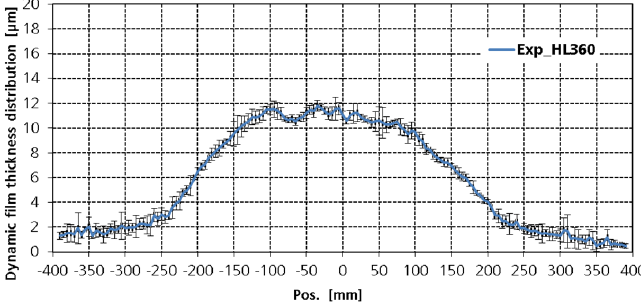
Figure 5. Measured dynamic film thickness distribution on a flat steel plate with the shaping air flow rate of 360 L/min.